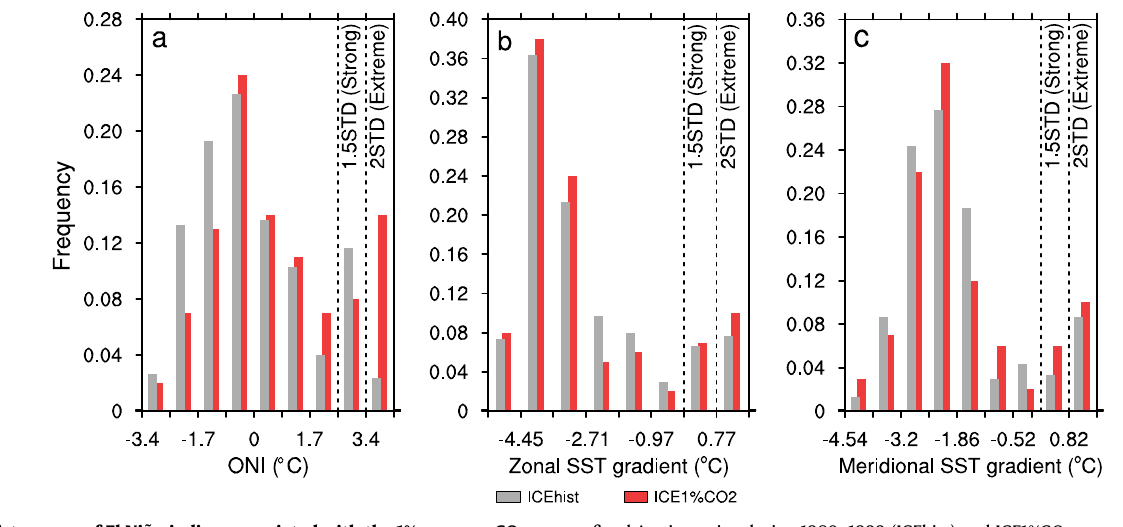
Fig. 7 | Histograms of El Nin ̃ o indices associated with the 1% per-year CO 2 increase experiment (ICE1%CO 2 ). a The Oceanic Nin ̃ o Index, b the zonal sea- surface temperature (SST) gradient in the equatorial Paci fi c, and c the meridional SST gradient. Gray and red bars are the time-slice-coupled model experiment with